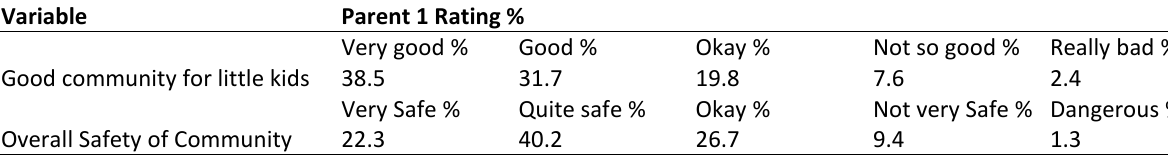
Table 4. Parent 1 community safety ratings (wave 6, n= 973). Variable